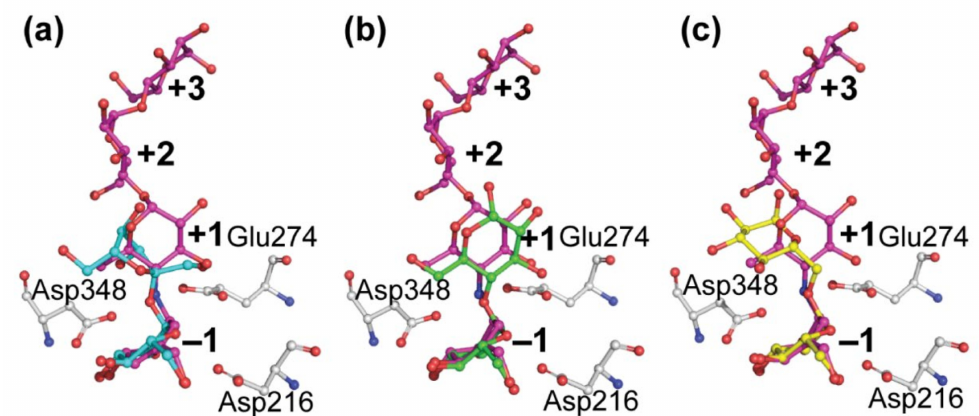
Figure 7. Positioning of acarbose (magenta) from Ba AG2 of B. adeninivorans superimposed with that of sucrose, maltose, and isomaltose. Sucrose (blue, a ) originates from the structure of sucrose hydrolase from B. mori (PDB: 6LGF). Maltose (green, b ) was taken from the structure of maltase from Bacillus sp. AHU2216 (PDB: 5ZCC) and isomaltose (yellow, c ) is from the structure of isomaltase IMA1 of S. cerevisiae (PDB: 3AXH). The catalytic triad of Ba AG2 is in grey. Binding subsites of acarbose are labelled with bold numbers. Structures were aligned and visualized with PyMol